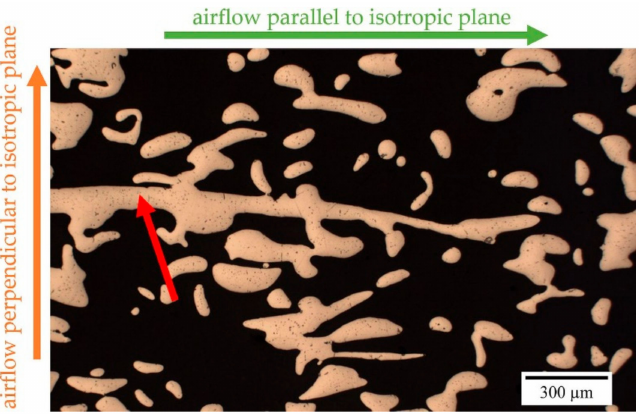
Figure 16. Cross section of an AlSi1 short-fiber structure with a single fiber cut lengthwise (red arrow) and arrows indicating the direction of airflow (the orange arrow corresponds to the orange arrow in Figure